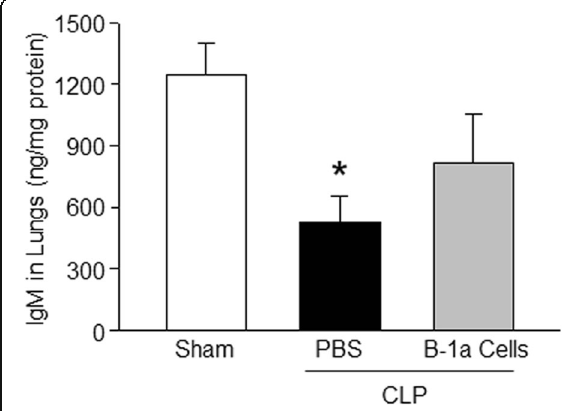
Fig. 5 Treatment with B-1a cells increases IgM levels in the lungs following sepsis. A total of 5 × 10 5 sorted B-1a cells were delivered into the peritoneal cavity of CLP mice. After 20 h, lung tissue was harvested from sham, PBS-, and B-1a cell-treated mice and assessed IgM levels in total extracted proteins by ELISA. Data are expressed as means± SE (n = 9 mice/group) and compared by one-way ANOVA and SNK method ( * p < 0.05 vs. sham mice). CLP, cecal ligation and puncture; ELISA, enzyme-linked immunosorbent